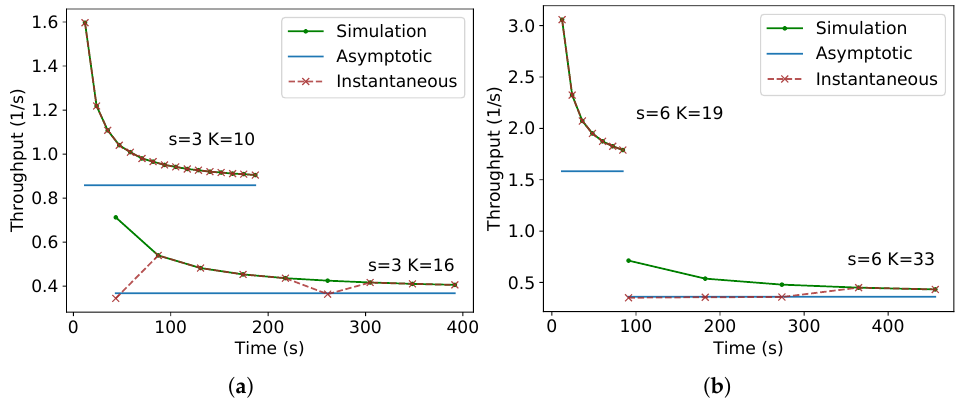
Figure 40. Throughput versus time comparison of the touch and run simulation on Stage with asymptotic values and the theoretical instantaneous equation for the throughput for different values of s and K . ( a ) s = 3 m and K ∈ { 10,16 } ; ( b ) s = 6 m and K ∈ { 19,33 } .